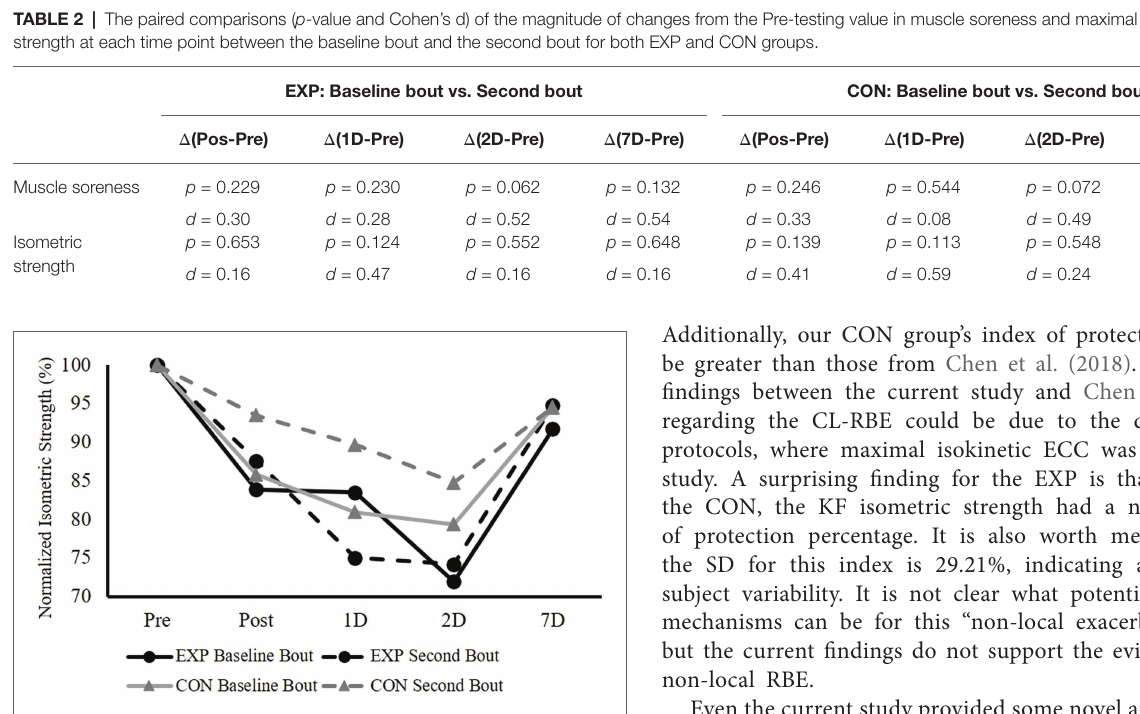
FIGURE 4 | The responses of KF maximal isometric strength (normalized as the percentage of the Pre-testing isometric strength) immediately after (Post), 1 day after (1D), 2 days after (2D), and 7 days after (7D) the baseline and the second bouts of ECC for both EXP and CON